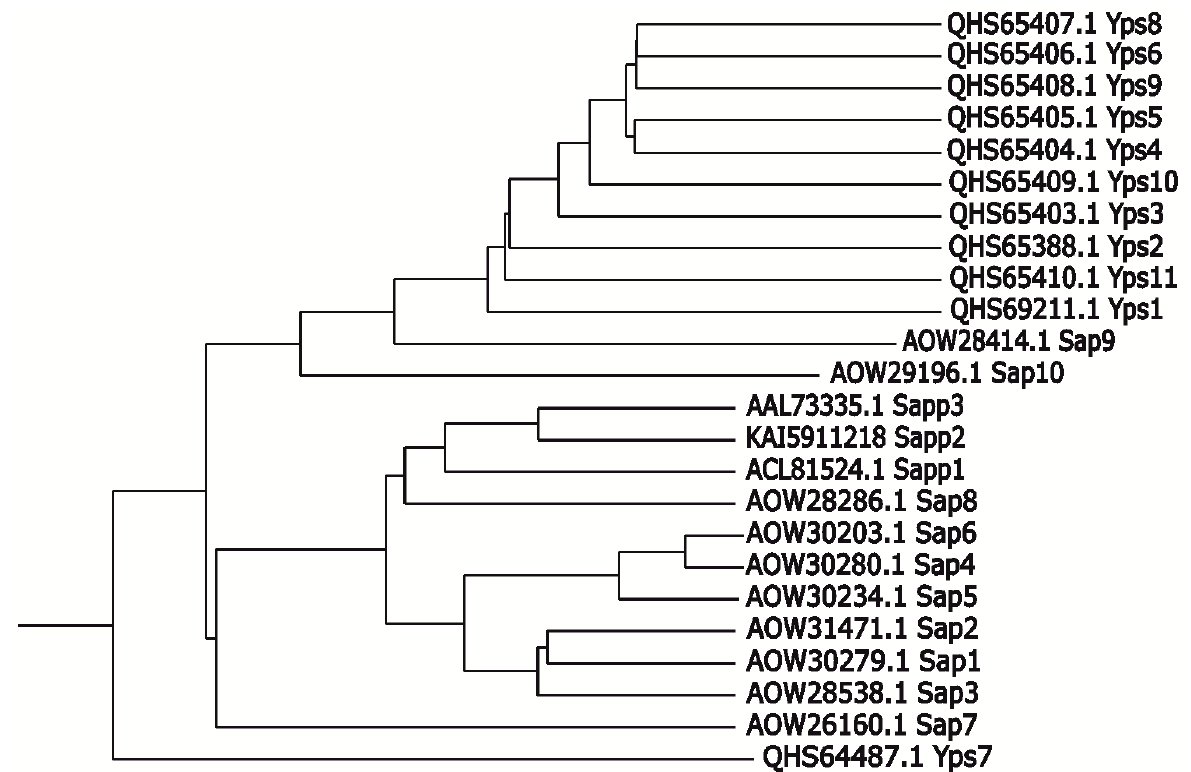
Figure 2. Dendrogram presenting the relationship of Candida spp. extracellular proteases. Prepared using the T-REX tool (http://www.trex.uqam.ca/) [37].